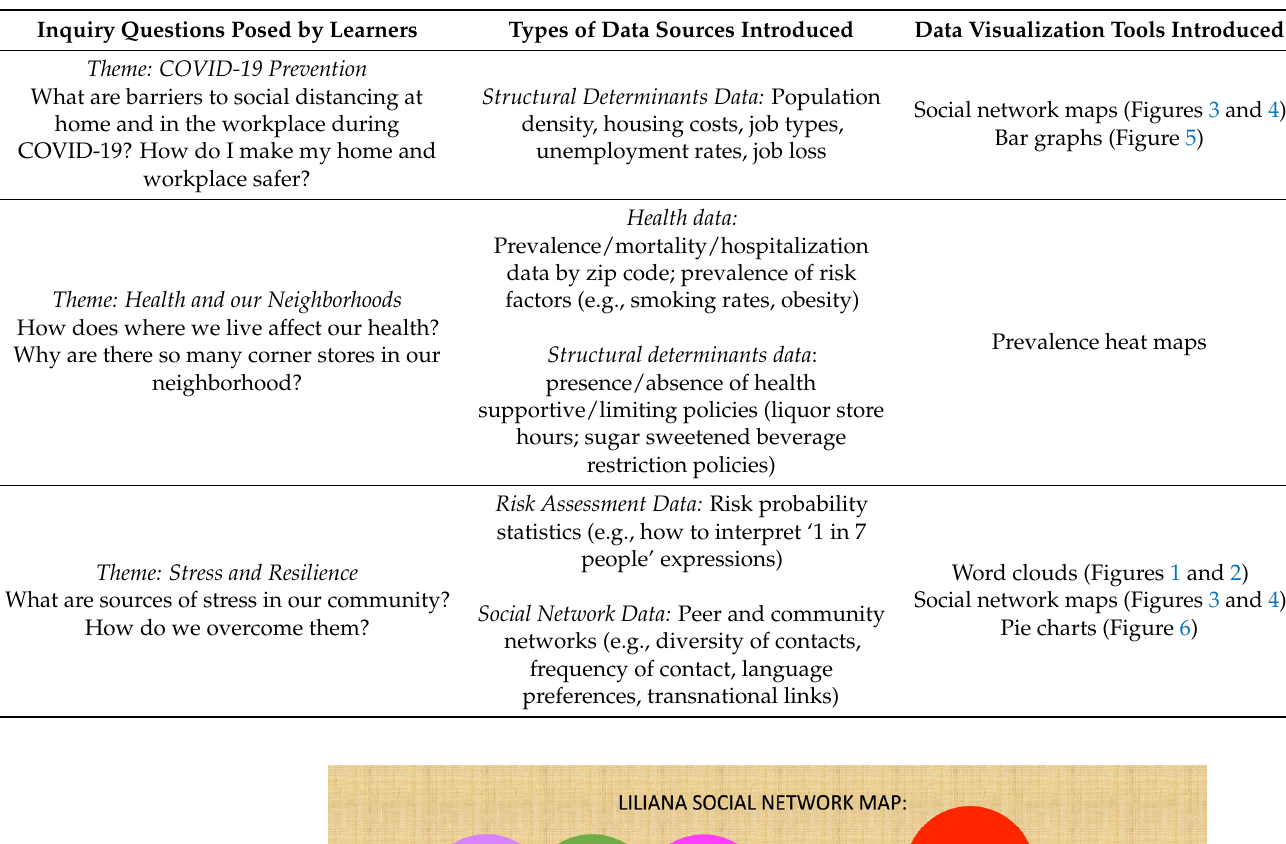
Table 1. Overview of data visualization work with immigrant Latina women in community-based English classrooms: Sample inquiry questions, data sources, and data visualization tools used to support learner inquiry.